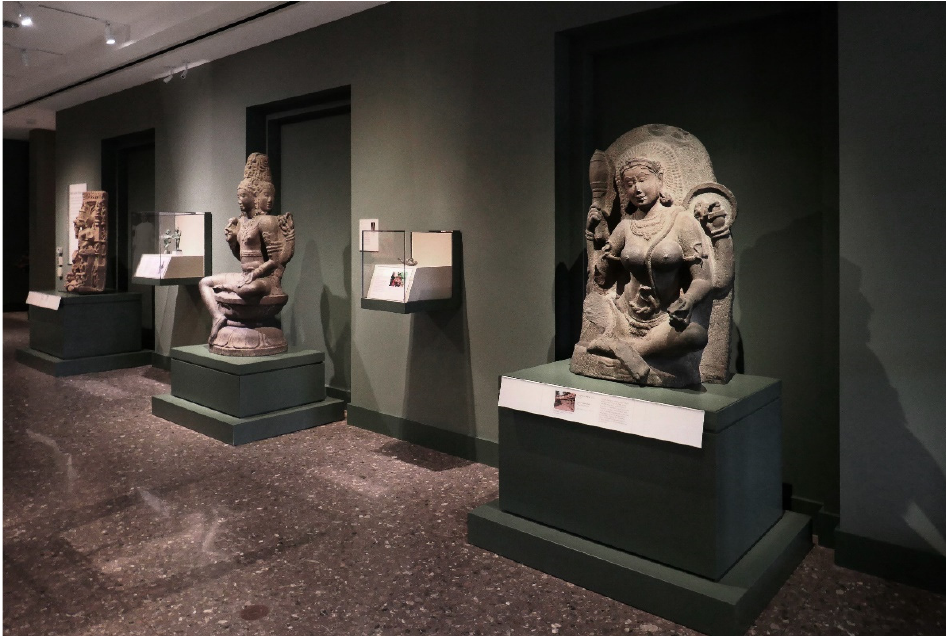
Figure 20. Gallery view of the yogini at the Detroit Institute of Arts, 2022. Photograph by Katherine E. Kasdorf.